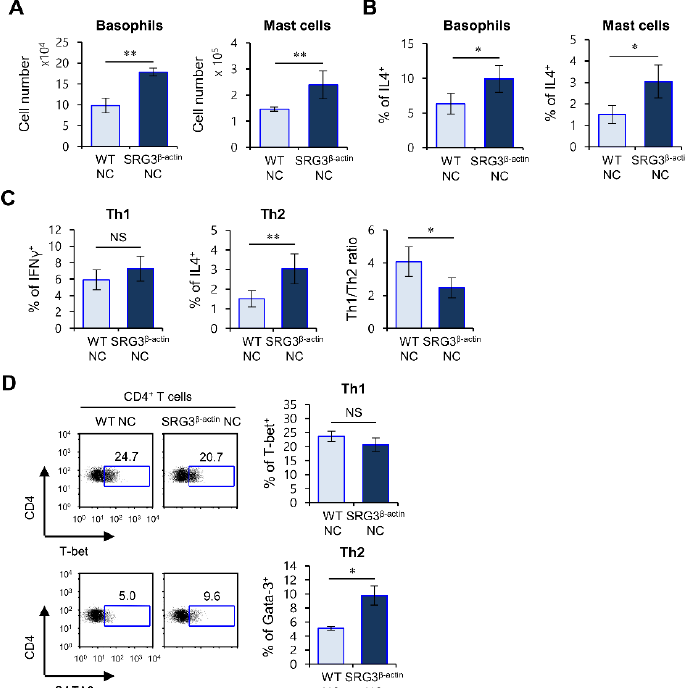
Figure 3. The effects of SRG3 overexpression on the severity of AD are associated with increased Th2 cell responses. ( A – D ) SRG3 β-actin NC and WT littermate NC mice maintained under barrier conditions were moved to conventional housing conditions at 6 weeks of age to develop AD spontaneously. Splenocytes were prepared from these mice at 14 weeks of age. ( A ) The absolute total cell numbers of both basophils and mast cells were determined in the spleen. ( B ) The percentages of IL4-producing cells among both basophils and mast cells were analyzed via flow cytometry. ( C ) interferon γ (IFNγ)- and IL4-producing populations in splenic CD4 + T cells from each group were determined by flow cytometry. ( D ) Intracellular T-bet and GATA binding protein 3 (GATA3) in CD4 + T cells were evaluated by flow cytometry. (( left ) panel) Representative fluorescence-activated cell sorting (FACS) plots. (( right ) panel) Summary of data. The mean values ± SD ( n = 5; per group in the experiment; Student’s t -test; * p < 0.05, ** p < 0.01) are shown. One representative experiment of two experiments is shown.